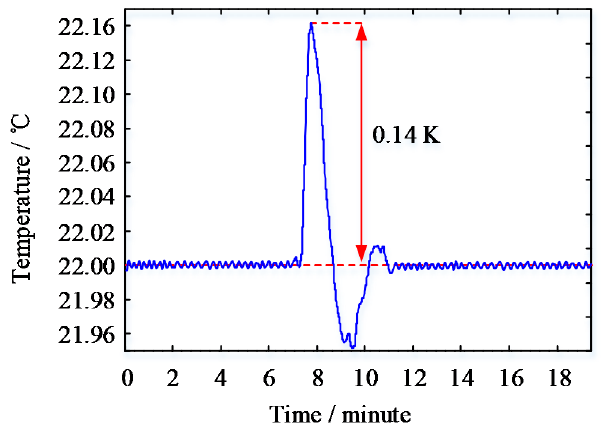
Figure 13. Experimental results of the 500 W thermal load impact response.